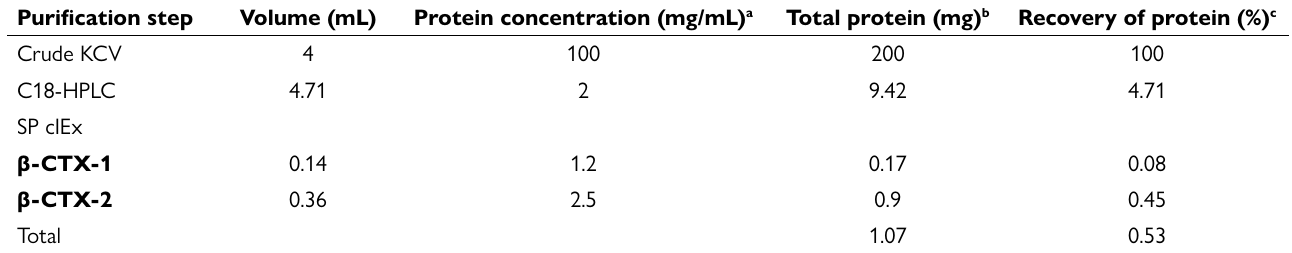
Table 2. Purification profiles of β-CTX from Thai KCV Purification